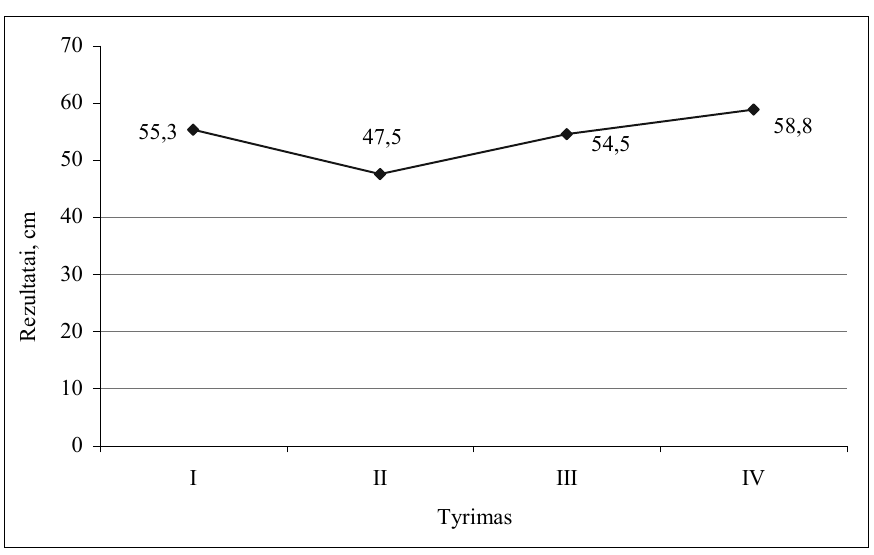
(II) taikymo (II—III tyrimo) — 5,1%, mažiausias (neigiamas) rezultat ų pokytis pasteb ė tas po j ė - gos lavinimo programos (I) taikymo (I—II